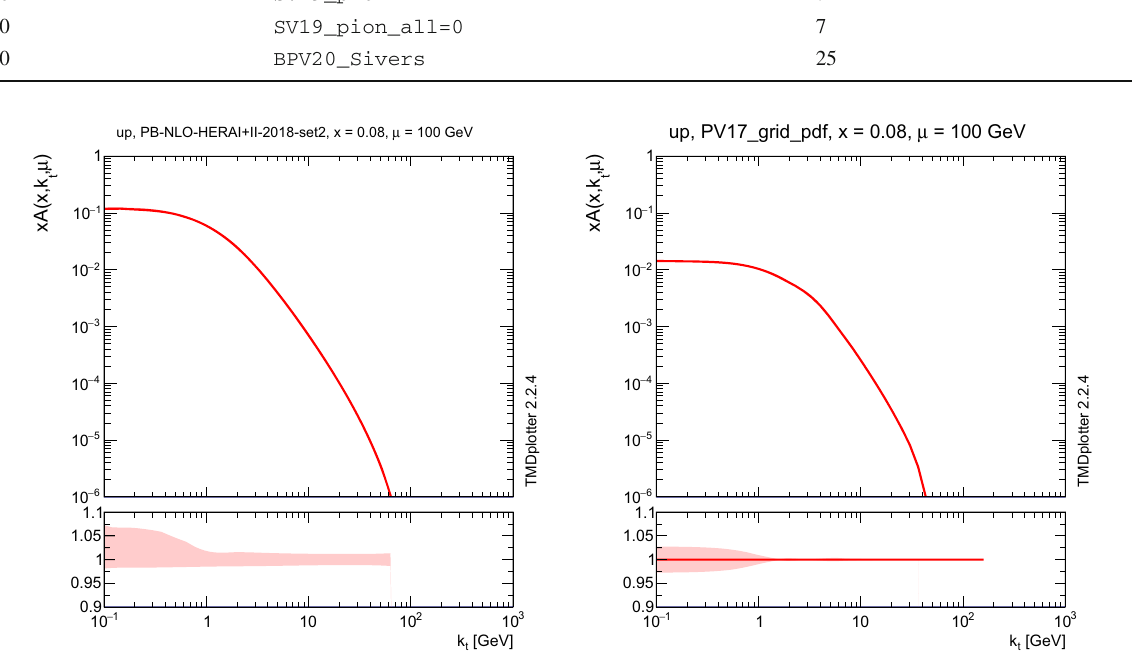
Fig. 2 Transverse momentum distribution x A ( x , k t ,μ) at x = 0 . 08 and μ = 100 GeV obtained with PB-NLO-HERAI+II-2018-set2 [45] (left) and PV17 [47] (right)